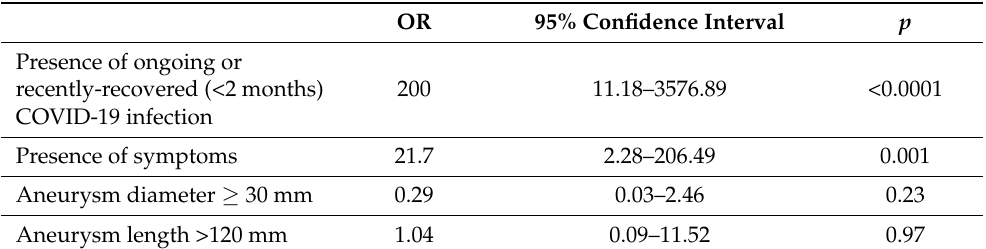
Table 3. Factors considered for statistical analysis as potentially affecting outcomes in 35 surgically treated patients.